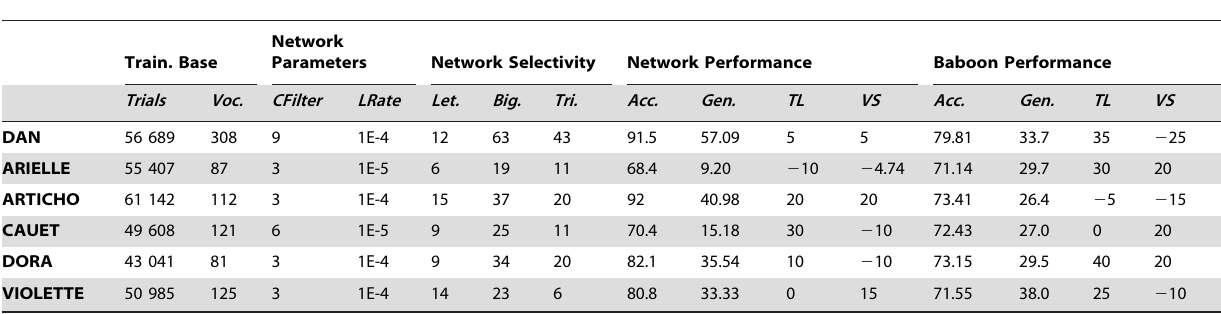
Table 1. Summary of networks parameters and performance.